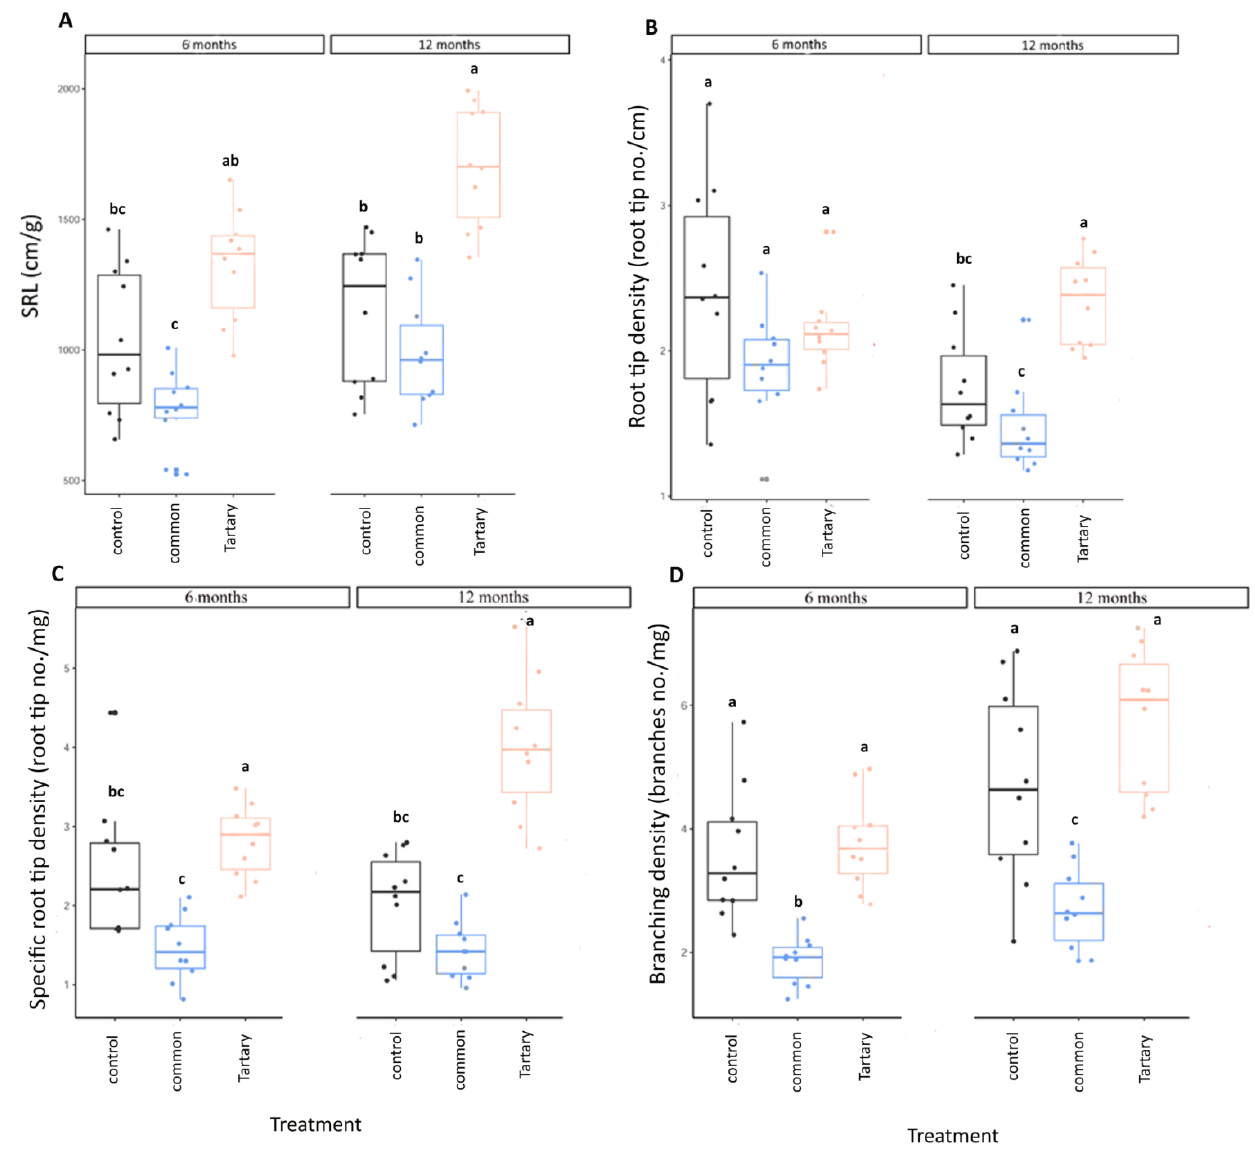
Figure 1. The impact of buckwheat husks on root parameters at 6 months and 12 months after spore inoculation: ( A ) specific root length (SRL) (cm/g); ( B ) root tip density (no. of root tips/cm); ( C ) specific root tip density (no. of root tips/mg) and ( D ) branching density (no. of branches/mg). Different letters mark statistically different results (Tukey HSD, p ≤ 0.05).